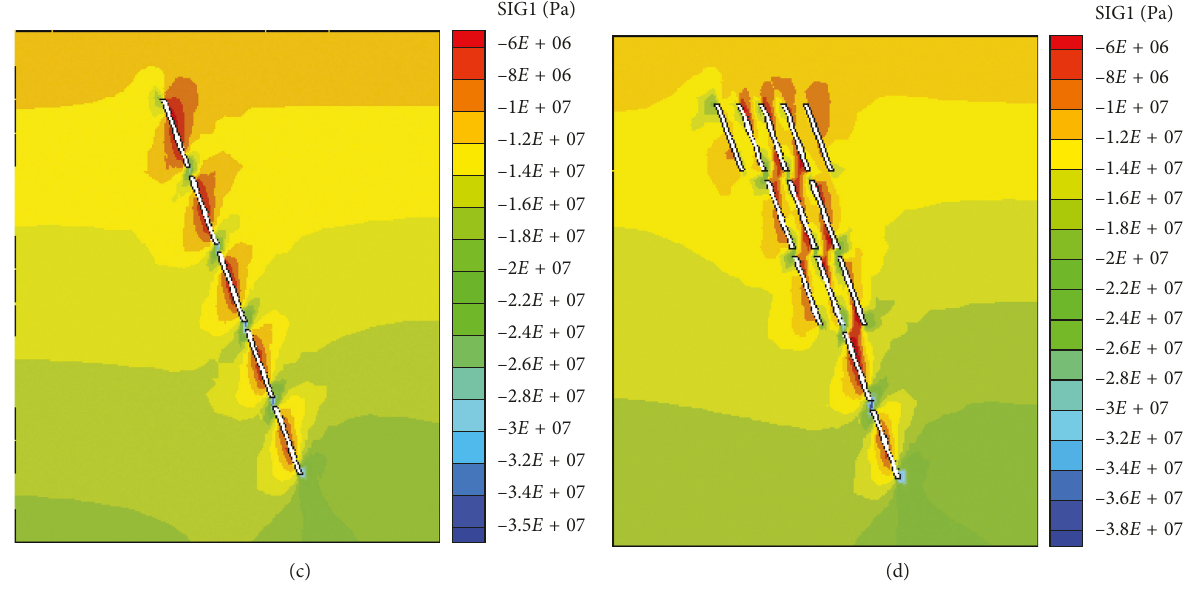
Figure 13: The principal stress nephogram. (a) Sequence 1. (b) Sequence 2. (c) Sequence 3. (d) Sequence